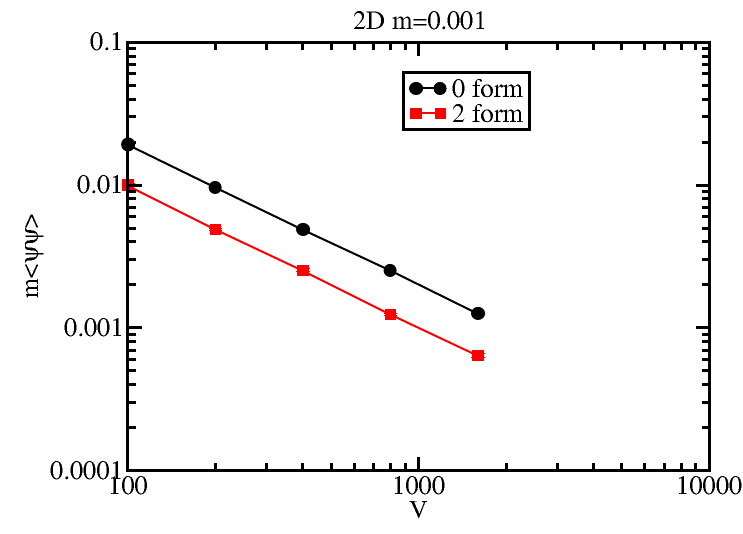
Figure 2 . Bilinear condensates vs volume on S 2 with m = 0 : 001 and (cid:12) = 0.